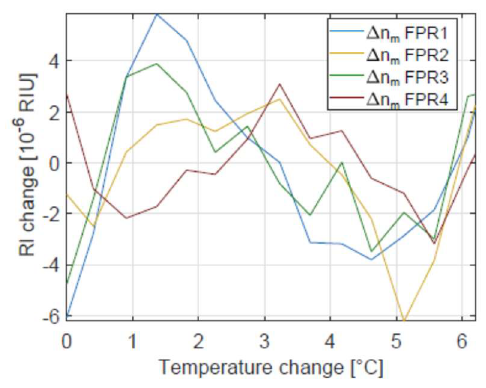
Fig. 6. Measurement of corrected RI change Δ 𝑛 𝑚 after temperature calibration of all open-cavity